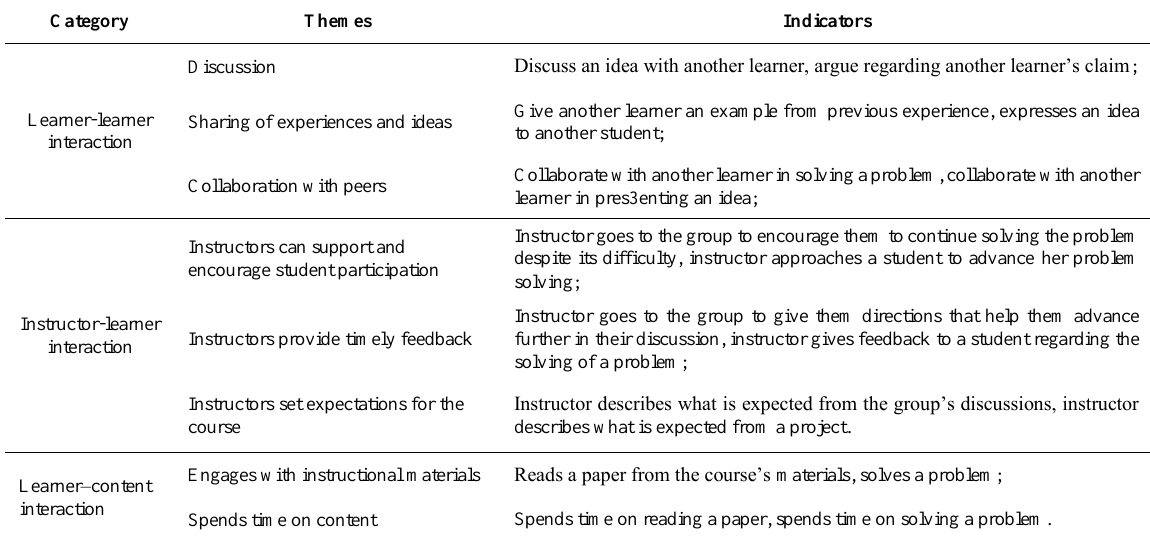
Table 1. Categories, themes and indicators for each theme according to Bolliger and